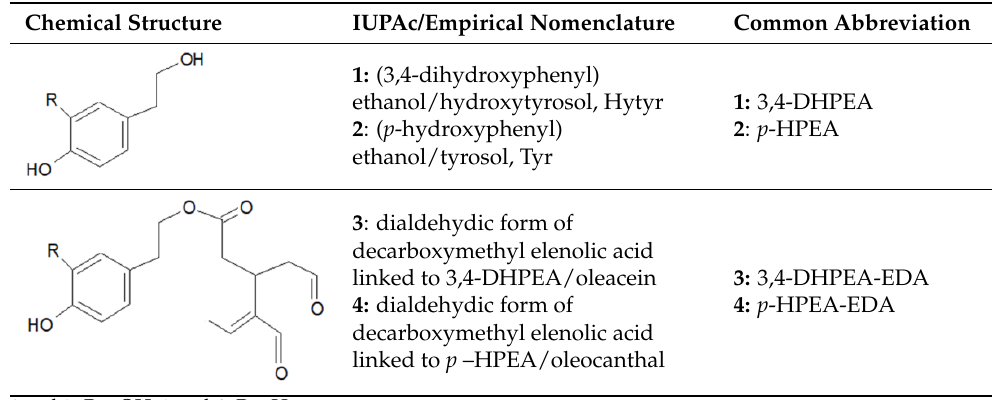
Table 1. Chemical structure, IUPAC/empirical nomenclature and common abbreviation of the most widely known oleuropein and ligstroside derivatives present in virgin olive oil.